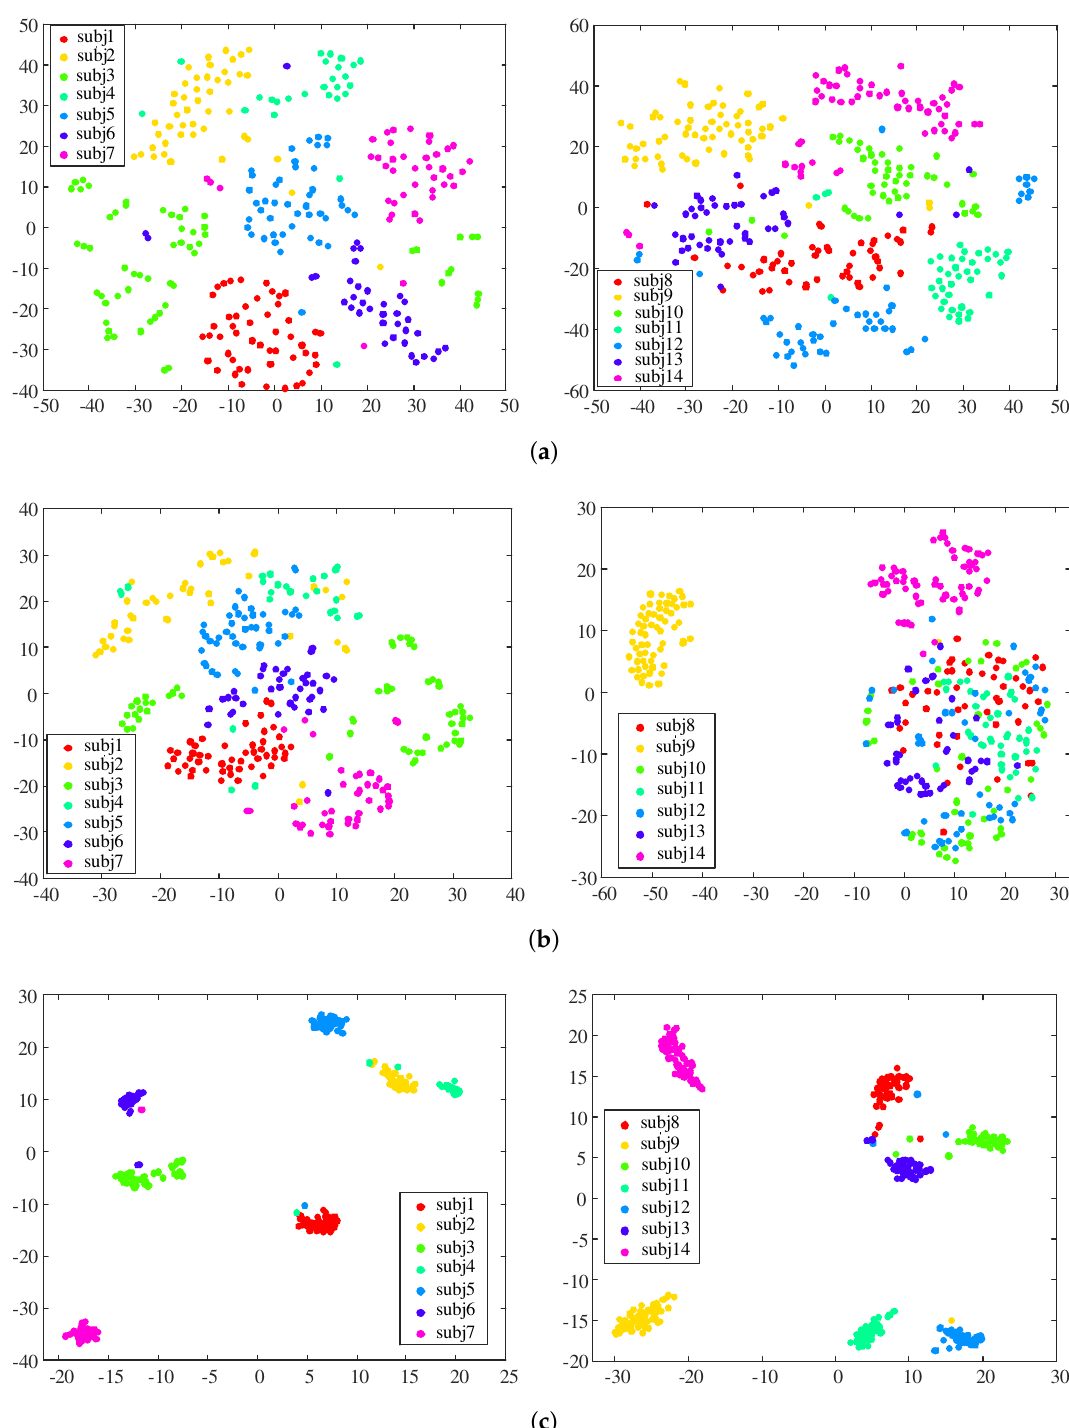
Figure 4. Distribution of individual step samples in each vector space: ( a ) input space of pressure data, ( b ) input space of acceleration data, and ( c ) multi-modal feature